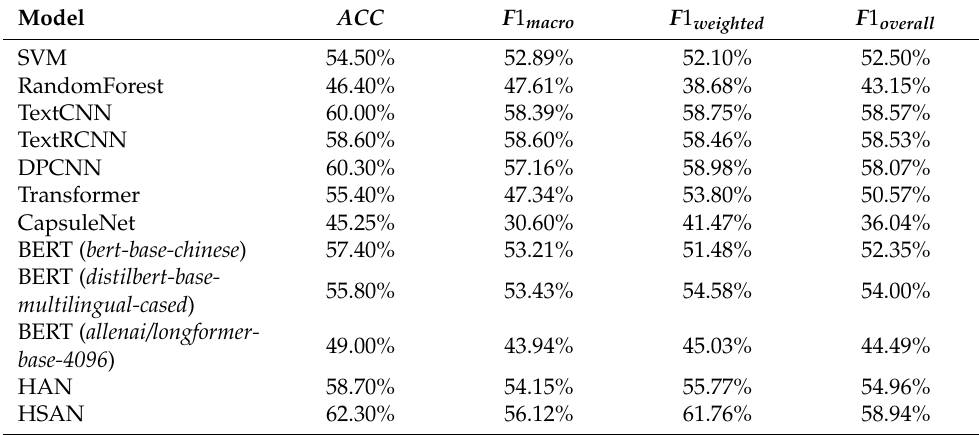
Table 8. Performance of HSAN with other popular